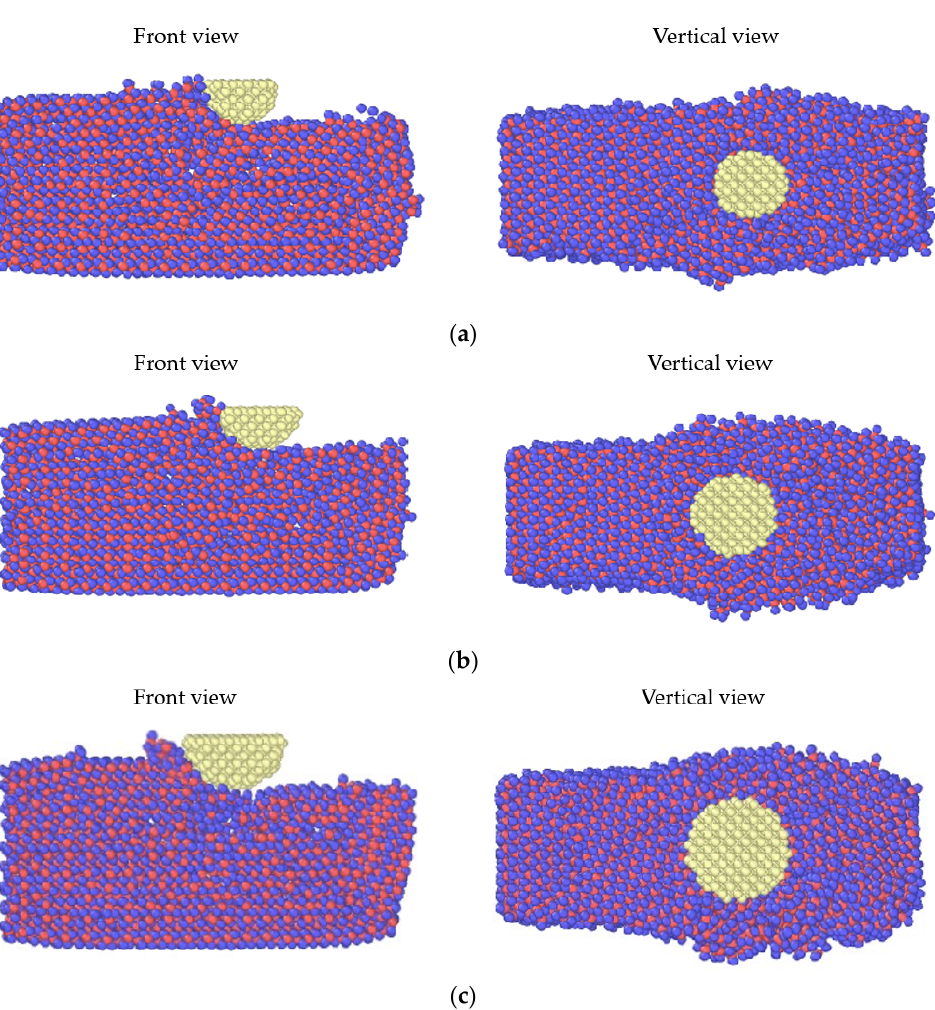
Figure 5. State diagram of micro-cutting simulation under different abrasive radii: ( a ) 8 Å, ( b ) 10 Å, ( c ) 12 Å.